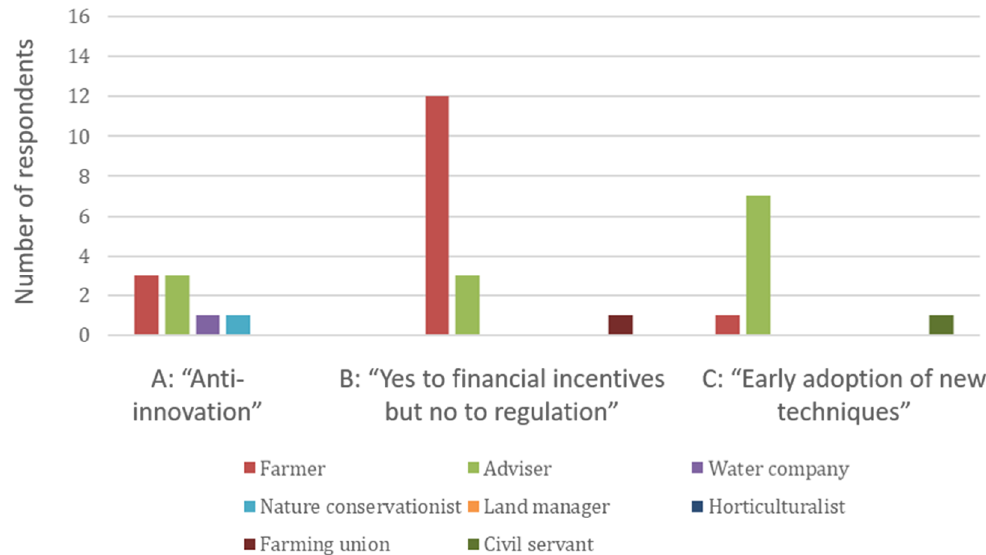
Figure 3. Professions of UK respondents loading onto the three solution factor groups.